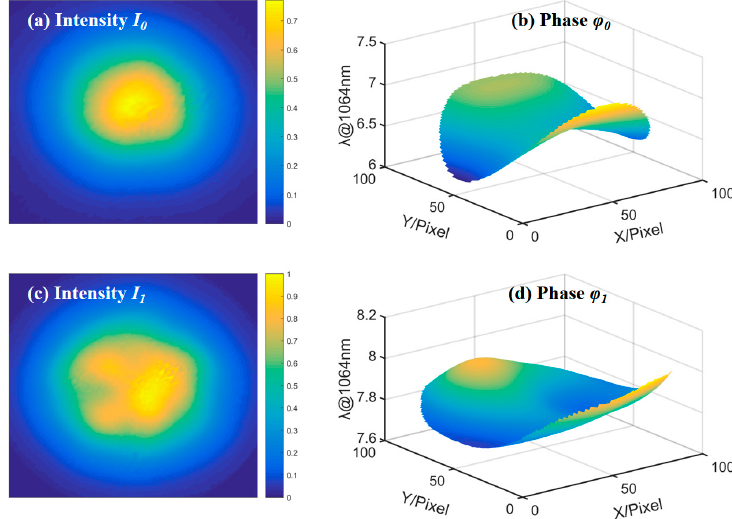
Figure 11. The measured complex amplitudes of the incident lasers.